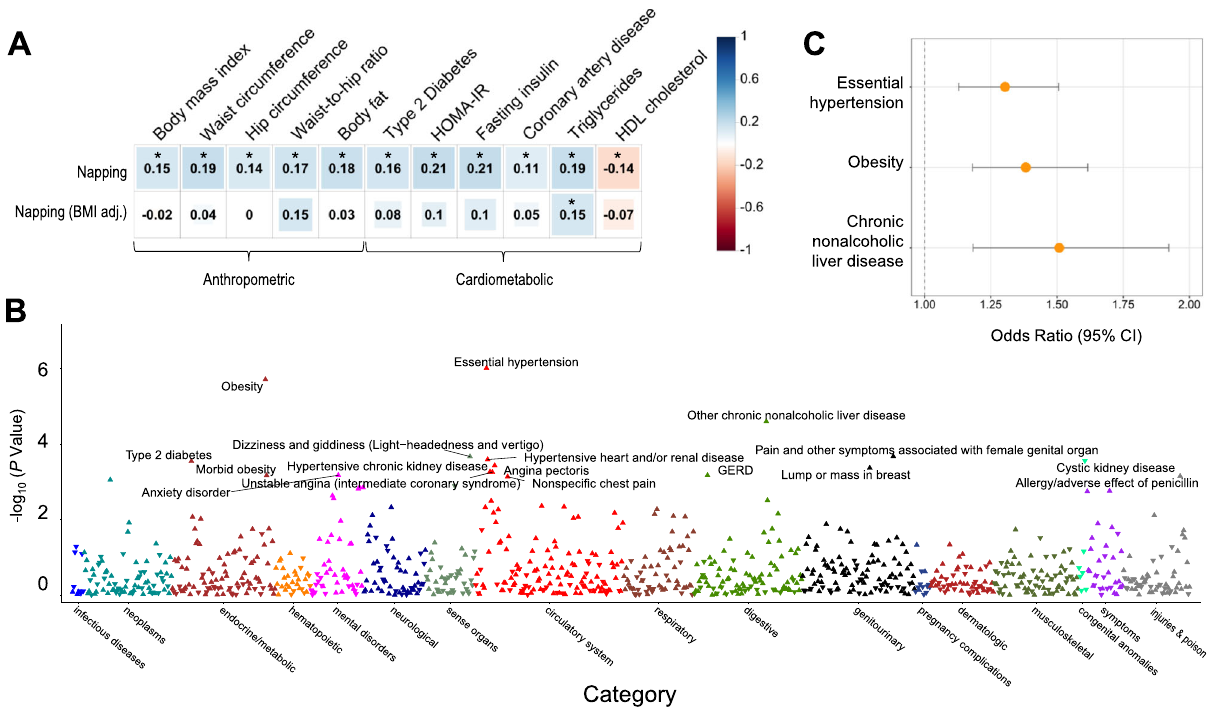
Fig. 4 Genome-wide genetic architecture of daytime napping correlations and associations with diseases and traits. A Shared genetic architecture between daytime napping and cardiometabolic diseases and traits. Linkage disequilibrium (LD) score regression estimates of genetic correlation ( r g ) were obtained by comparing genome-wide association estimates for daytime napping (without and with BMI adjustment) with summary statistics estimates from 257 publicly available genome-wide association studies. Blue indicates positive genetic correlation and red indicates negative genetic correlation; r g values are displayed for signi fi cant correlations. Larger colored squares correspond to more signi fi cant P values. Asterisk denotes signi fi cant false discovery rate (FDR) corrected P values. Full genetic correlations for all 257 traits can be found in Supplementary Data 10. B Manhattan plot of phenome-wide association fi ndings for daytime napping genome-wide polygenic score in Mass General Brigham Biobank ( n = 23,561). The x -axis is color-coded phecodes organized by broad disease categories and the y -axis is P value of association ( − log 10 P ). The horizontal red line depicts phenome-wide signi fi cance using Bonferroni correction for all tested diseases (951 diseases), and the horizontal blue line depicts phenome-wide signi fi cance using FDR correction. Upward arrows denote positive associations (OR > 1), and downward arrows denote inverse associations (OR < 1). Full results for all 951 diseases can be found in Supplementary Data 11. C Cross-sectional association between quartile 10 and quartile 1 (reference group) of daytime napping genome-wide polygenic score and essential hypertension, obesity, and chronic nonalcoholic liver disease in the Mass General Brigham Biobank ( n = 23,561). Error bars represent the 95% con fi dence intervals for